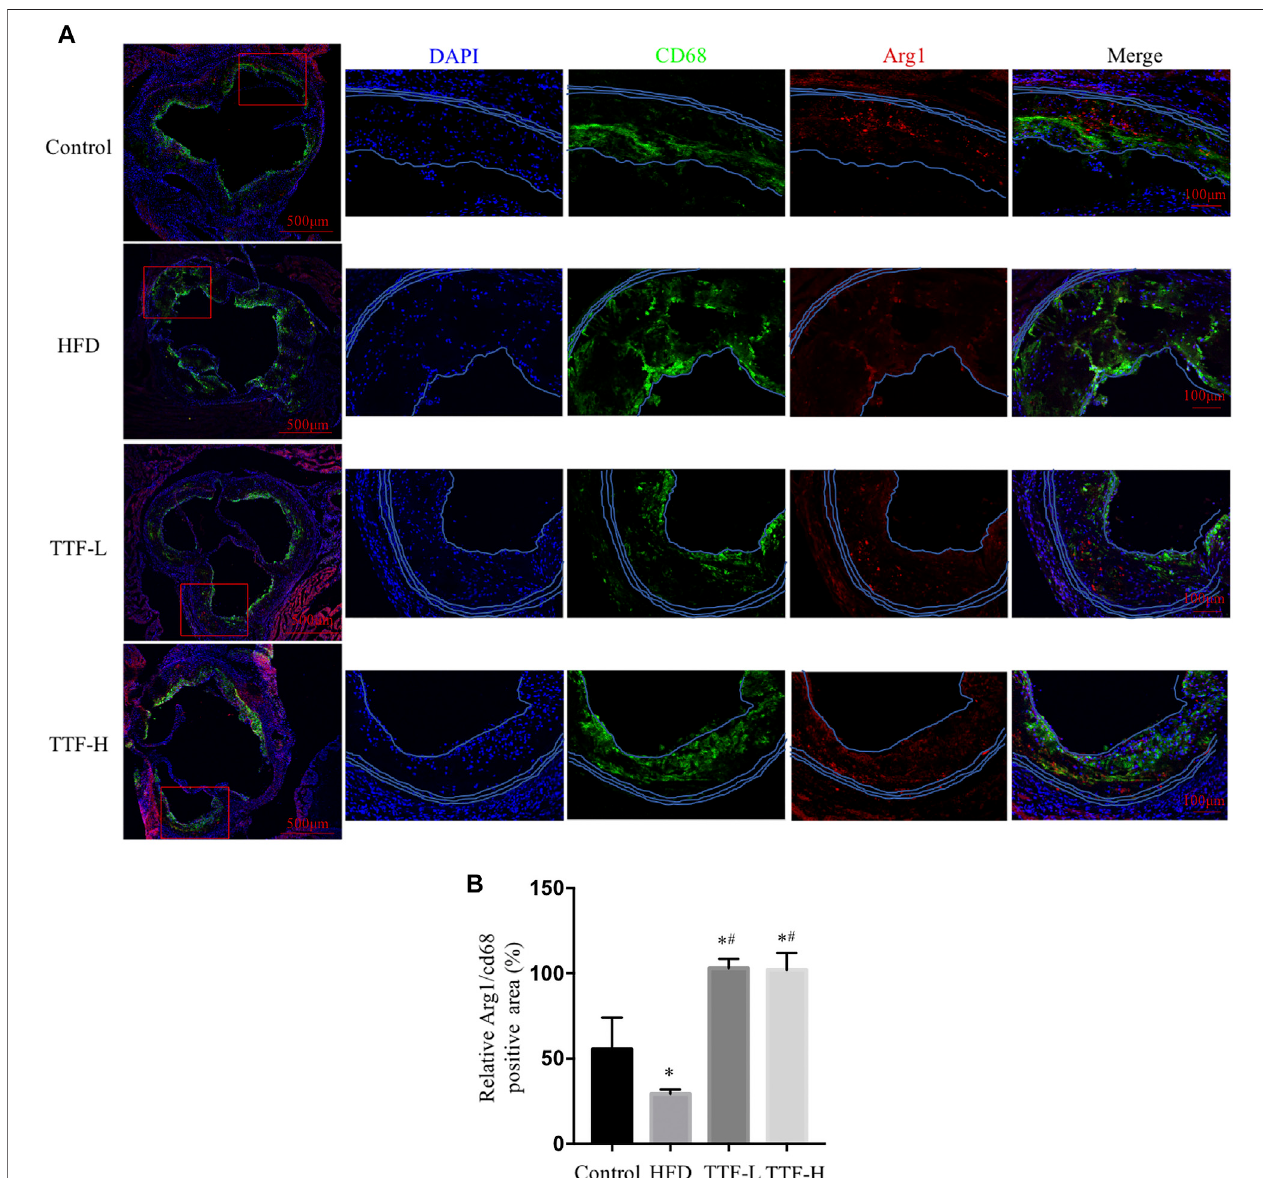
FIGURE 5 | TTF increases the expression of alternative macrophage in atherosclerotic plaque of ApoE -/- mice (A) Representative images of immuno fl uorescence staining of aortic sinus. Bar (cid:2) 50 μ m. Blue for DAPI, green for CD68 and red for Arg1 (B) the quantitative analysis of relative Arg1/CD68 positive area. Values are presented as means ± SEM (n (cid:2) 3 per group). * p < 0.05 vs Control group, # p < 0.05 vs HFD